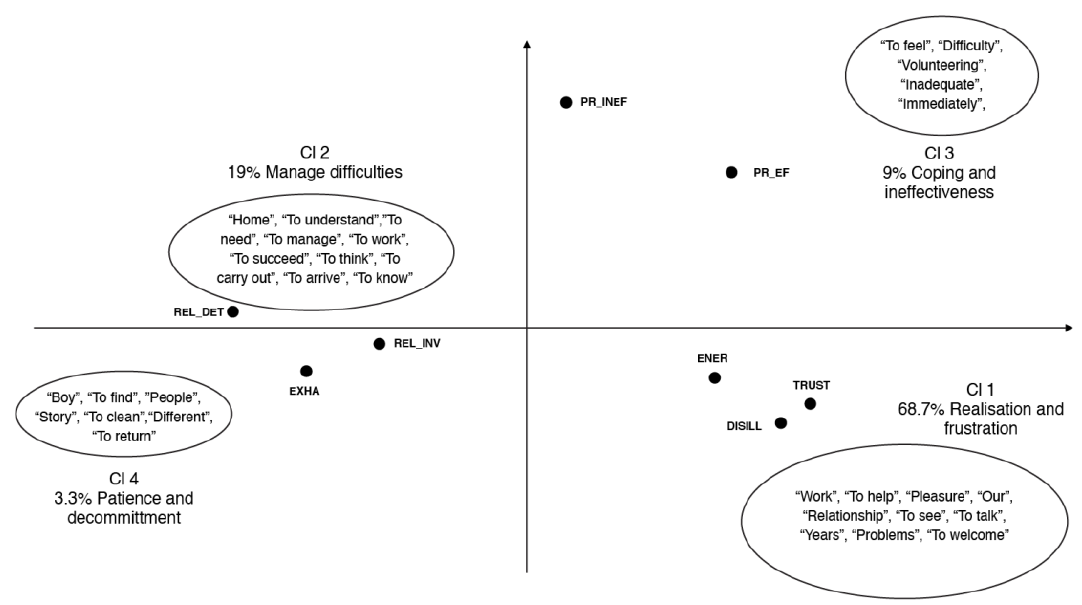
Figure 1. Representation of the clusters and descriptive variables on the factorial plane for the first-level structures. The descriptive variables are: Exhaustion (EXHA), Energy (ENER), Relational deterioration (REL_DET), Relational involvement (REL_INV), Professional inefficacy (PR_INEF), Professional efficacy (PR_EFF), Disillusion (DISILL), Trust